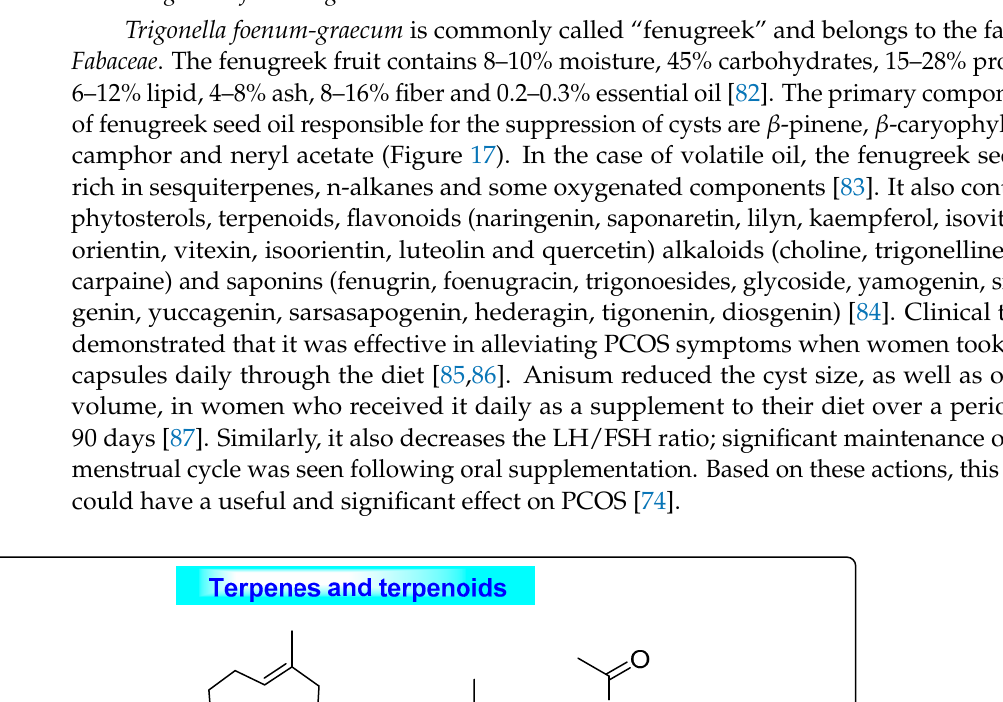
Figure 17. Terpenes and terpenoids of Trigonella foenum-graecum that suppress cyst formation.